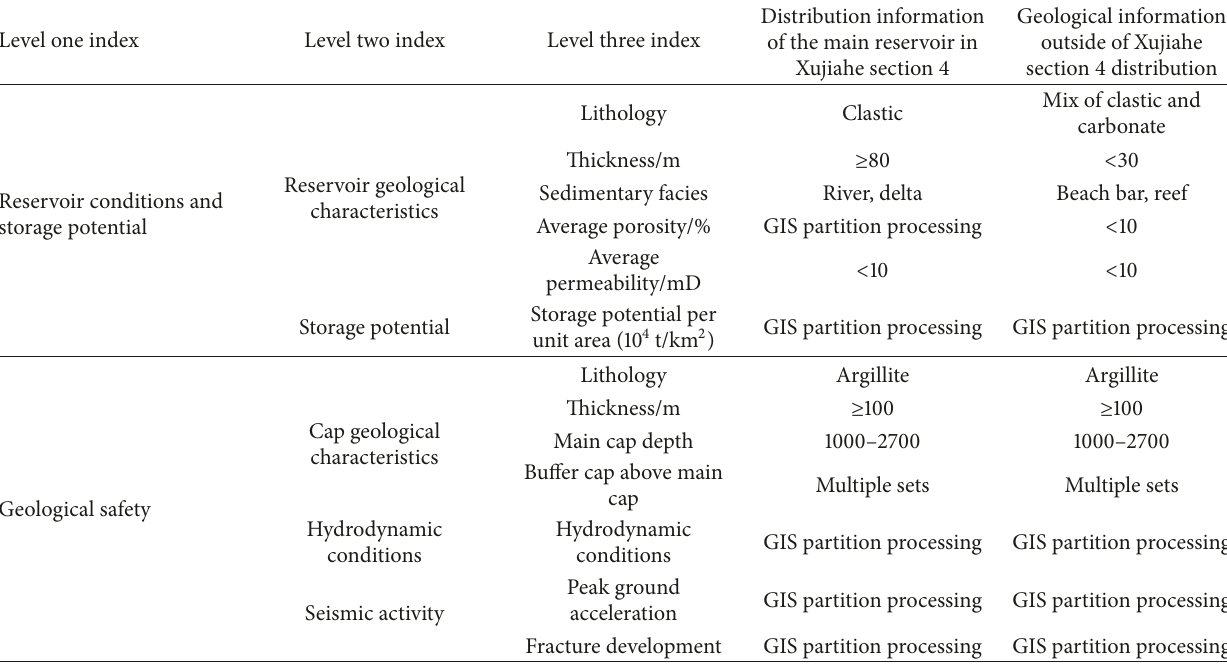
Table 12: Geological suitability assessment information of the main reservoir distribution area (within section four of Xujiahe formation). Level one